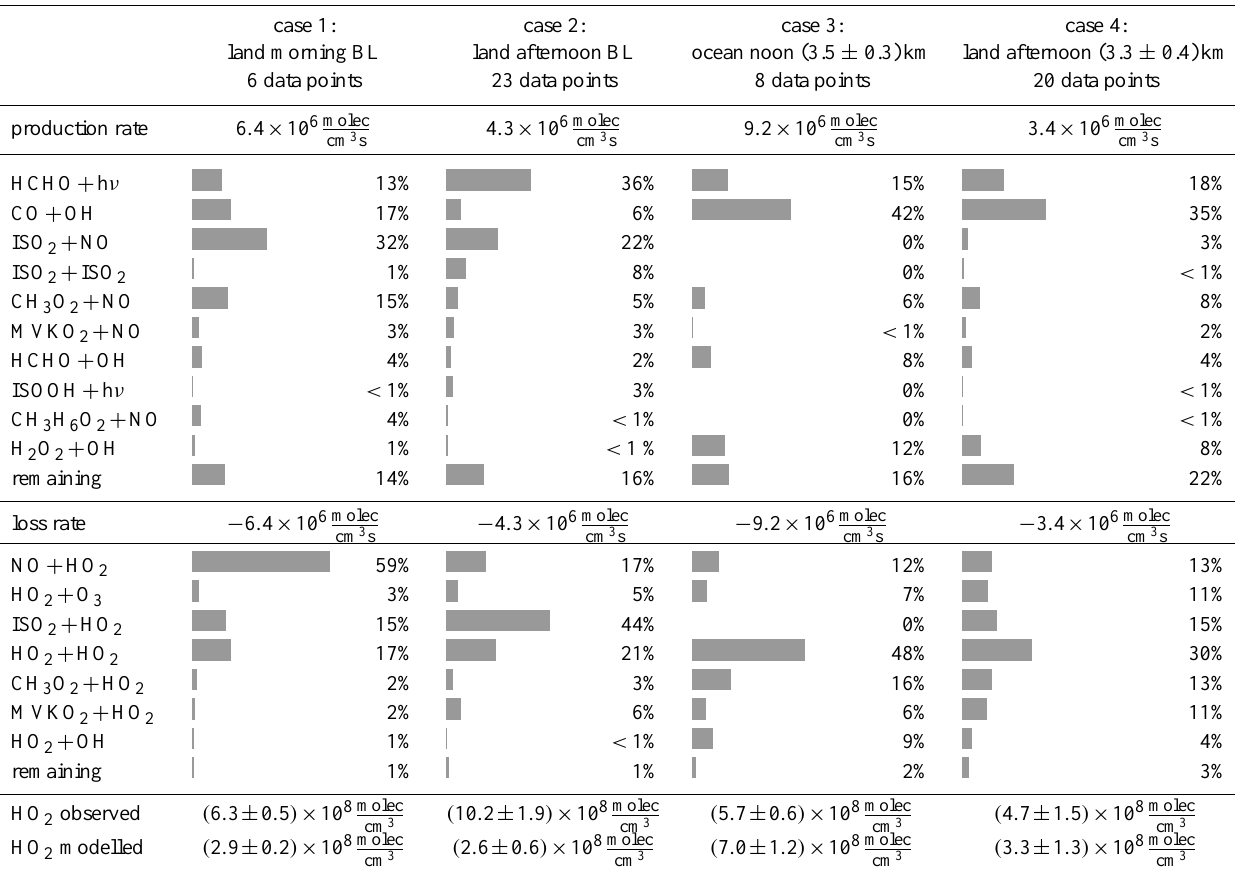
Table 8. HO 2 budget based on a model analysis of measurement data.